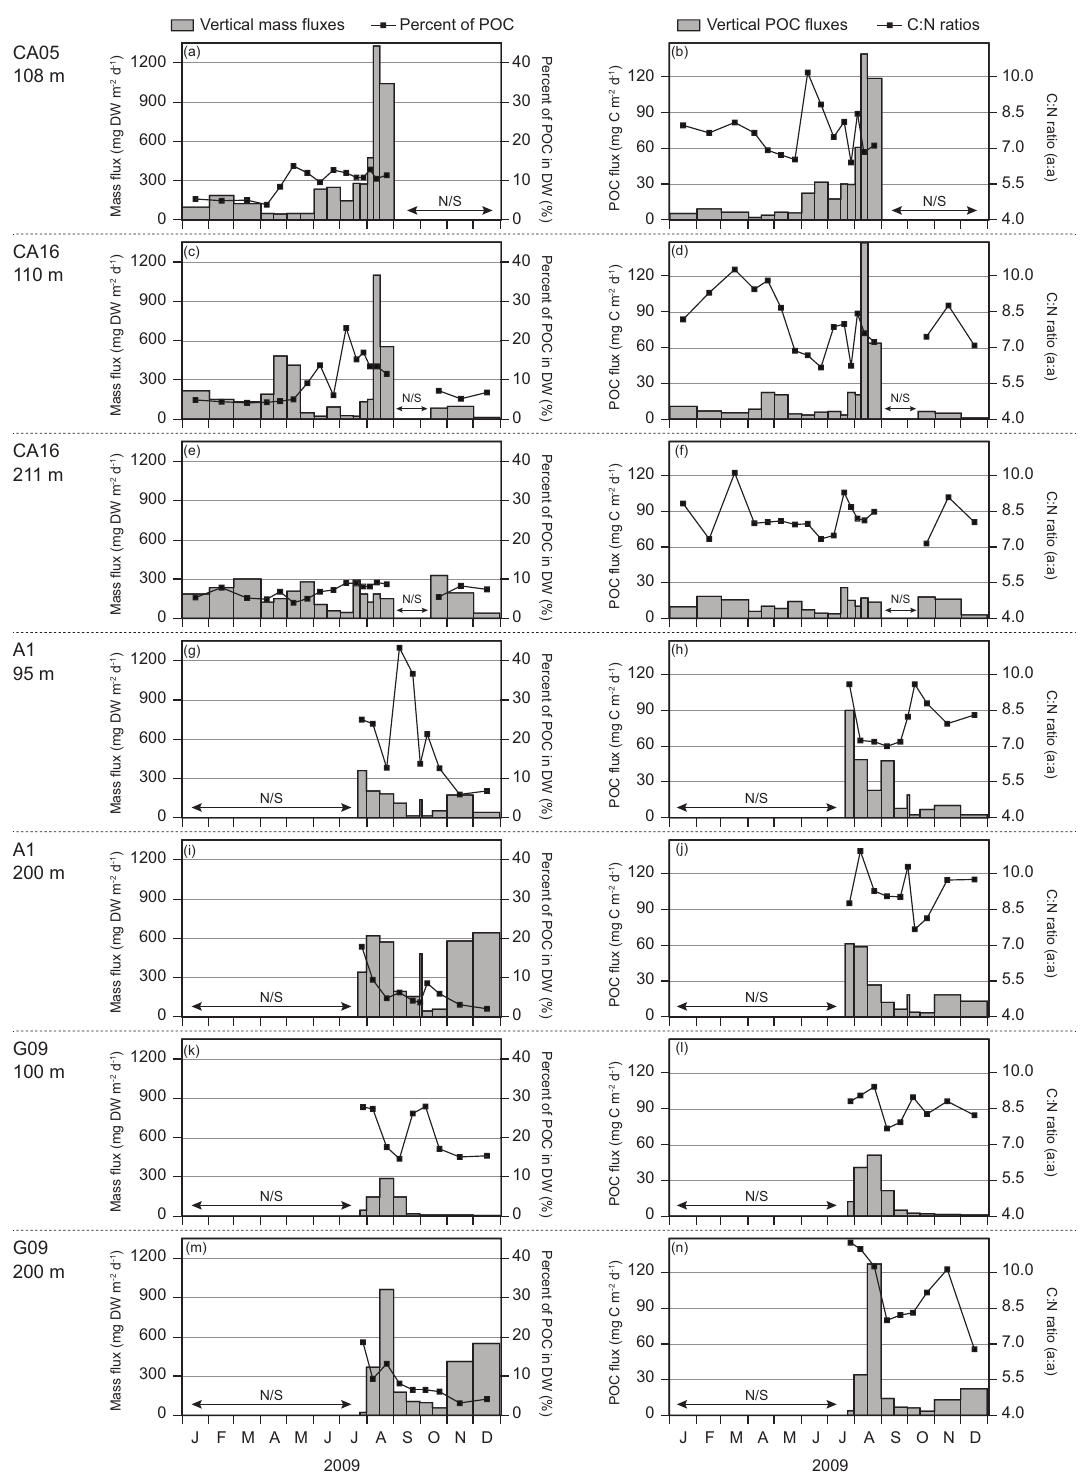
Fig. 6. Time series from January to December 2009 of daily vertical mass fluxes (dry weight, DW) and particulate organic carbon fluxes (POC) recorded at ∼ 100 and ∼ 200m depth at moorings CA05 (a–b) , CA16 (c–f) , A1 (g-j) , and G09 (k-n) deployed around the Mackenzie Shelf. The corresponding percentage of POC in total DW as well the C:N ratio of each sediment trap sample are illustrated as a line over the vertical mass fluxes and POC fluxes, respectively. The location of the long-term moorings is given in Fig. 1 and details of the deployments in Table 1. N/S: no